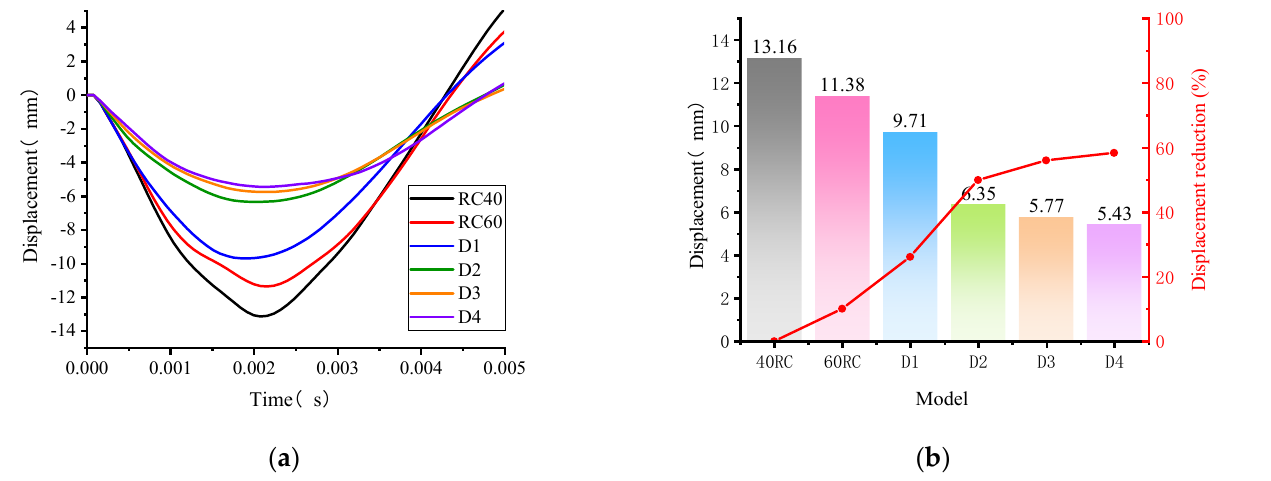
Figure 11. Displacement ( a ) Displacement curve of the vault ( b ) Peak displacement and percentage reduction.